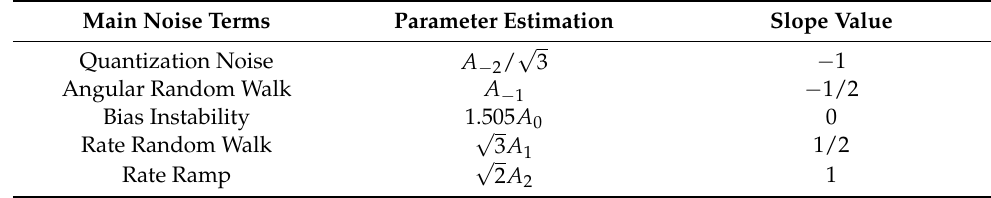
Table 1. Parameter estimation and slope of noise term